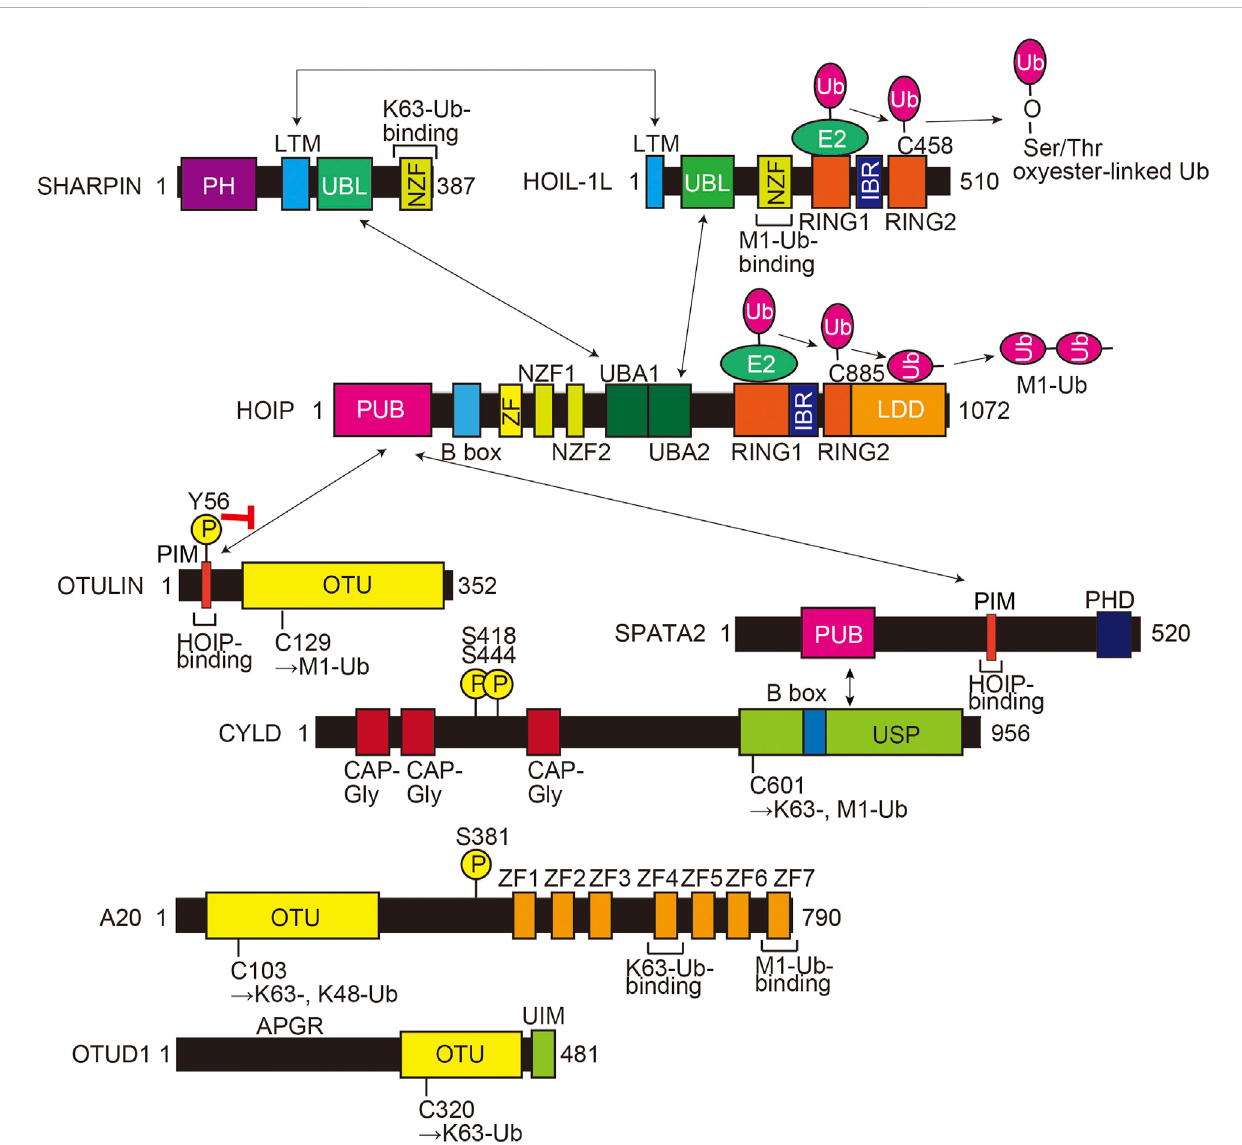
FIGURE 1 Domain structures and interactions of LUBAC subunits (HOIL-1L, HOIP, and SHARPIN) and LUBAC-related DUBs (OTULIN, CYLD-SPATA2, A20, and OTUD1).Theinteractionsitesareshownbyarrows,andaredinhibitoryarrowindicatessuppressedHOIP-bindingbyphosphorylationofTyr56inOTULIN.The E3 catalytic mechanisms of HOIL-1L and HOIP are also indicated. The active center and ubiquitin chain speci fi city of each DUB are shown. PH, Pleckstrin- homology;LTM, LUBAC-tethering motif; UBL, ubiquitin-like; NZF, Npl4-typezinc fi nger;RING, really interesting new gene; IBR, in-between RING; PUB, PNGase/UBA or UBX; B box, B-box-type zinc fi nger domain; ZF, zinc fi nger; UBA, ubiquitin-associated; LDD, linear ubiquitin chain determining domain; PIM, PUB domain-interacting motif; OTU, ovarian tumor protease; PHD, plant homeodomain; CAP-Gly, cytoskeleton-associated protein Gly-rich domain; USP, ubiquitin-speci fi c protease; APGR, Ala-, Pro-, and Gly-rich region; UIM, ubiquitin-interacting motif; Ub, ubiquitin; encircled P, phosphorylation